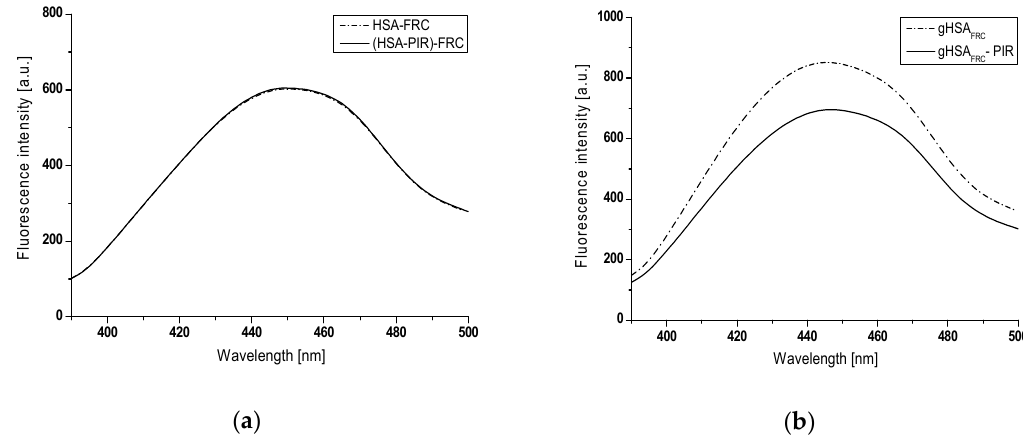
and after 21 days of incubation at 37 °C (b), at excitation wavelength λ ex = 370 nm.